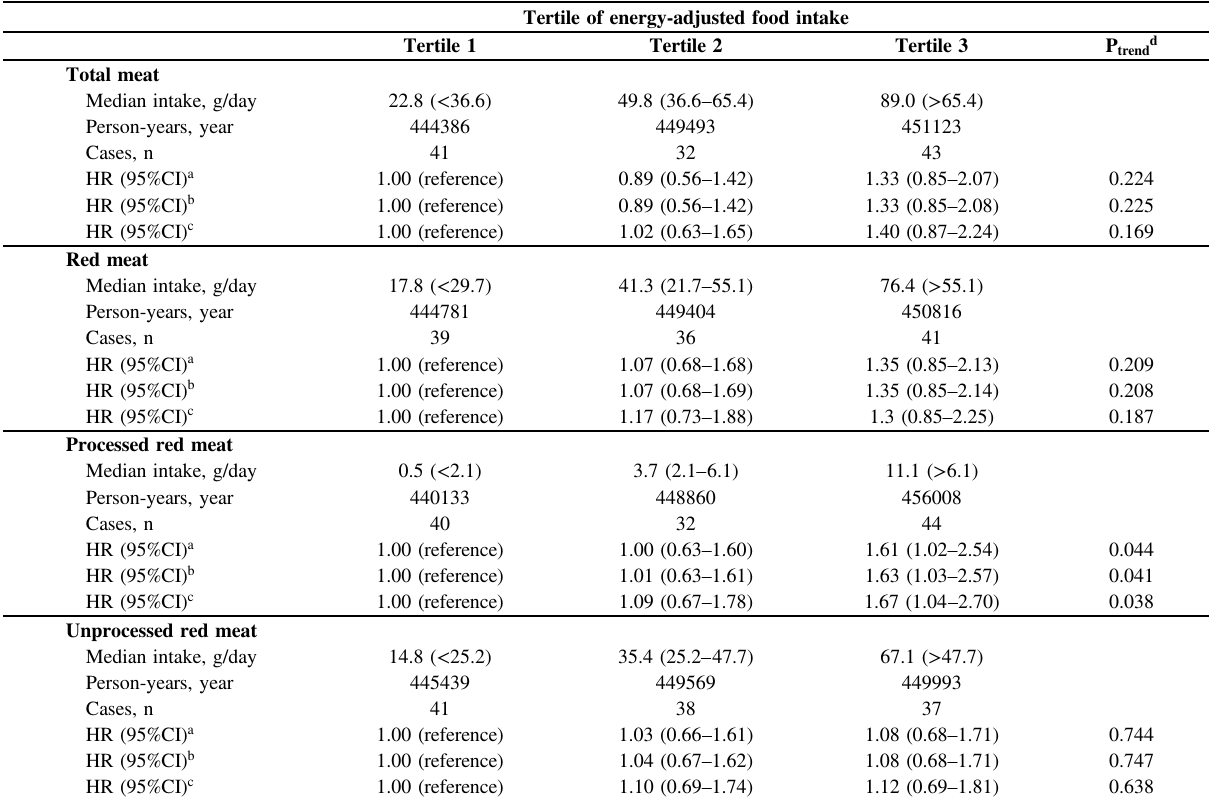
Table 2 Acute myeloid leukemia and myelodysplastic syndrome risk by meat, fi sh and fatty acids